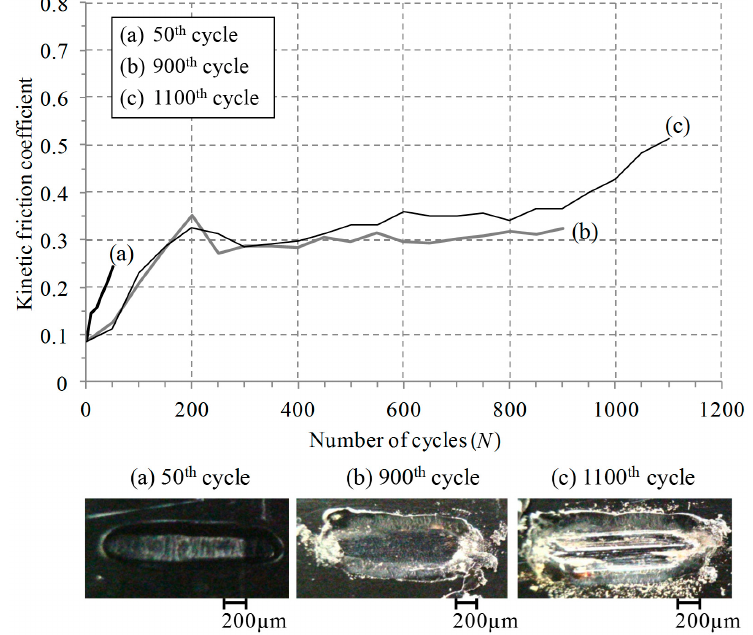
Figure 2. The friction coefficient evolution of an electro-deposited coating at a normal force of 25 N, a displacement of 1 mm, and a frequency of 1 Hz.